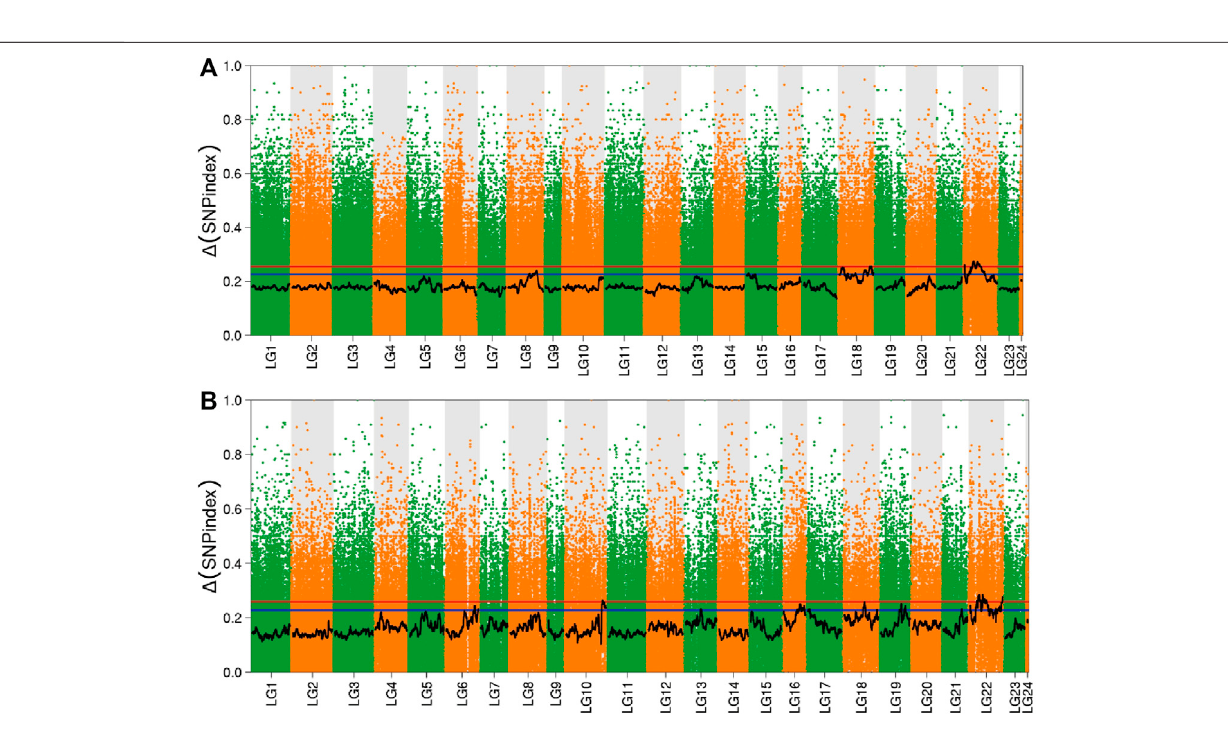
Frontiers in Genetics |